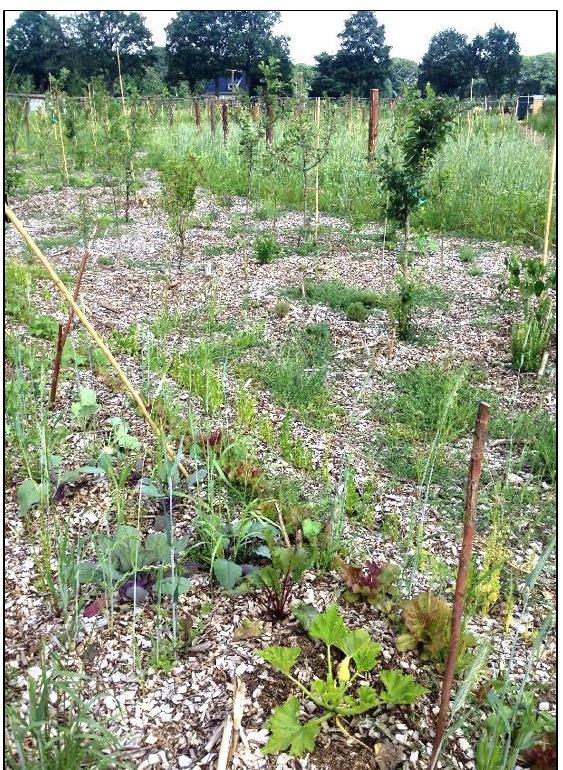
Figure 2. Den Food Bosch in 2018, Nine Months After Planting on Seven Different